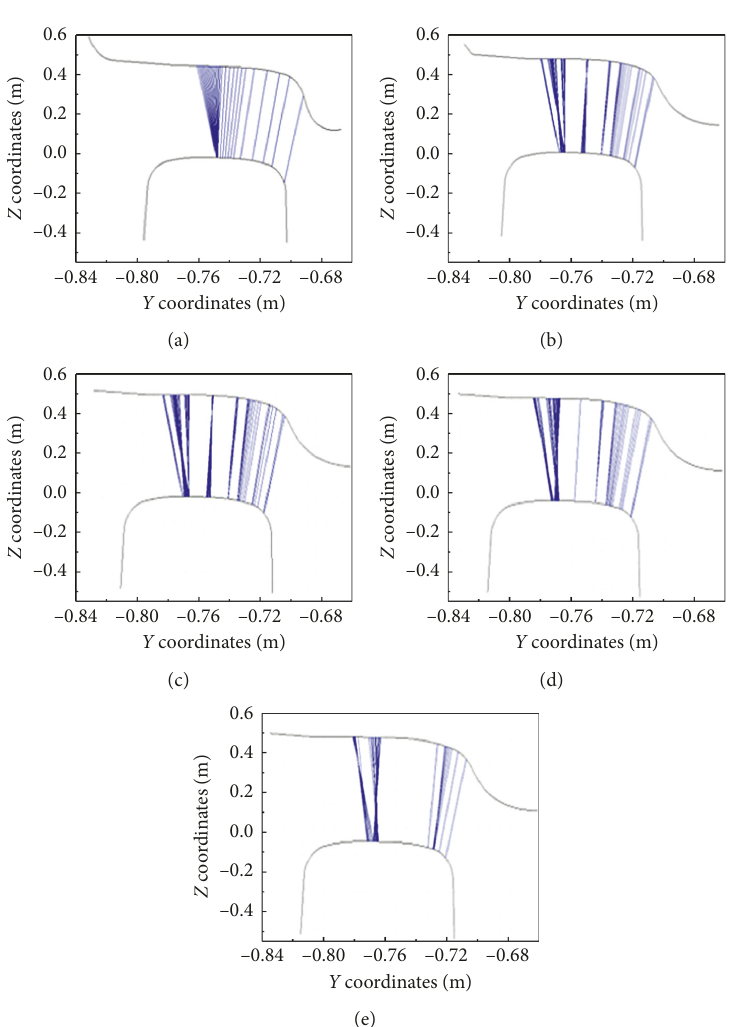
Figure 11: Distribution of wheel-rail contact points of new and worn profiles: (a) new profile; (b) 83,0000 km; (c)132,000 km; (d) 169,000km; (e) 192,000km.